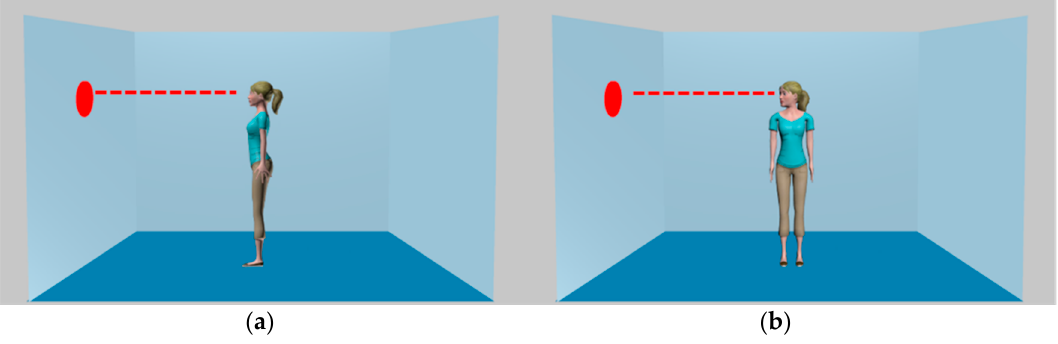
Figure 1. Gaze-maintained ( a ) and gaze-averted ( b ) avatars used in Experiments 1 and 2, illustrating that there is unbroken light of sight between the target dot and the avatar in both cases (right facing avatars not illustrated).